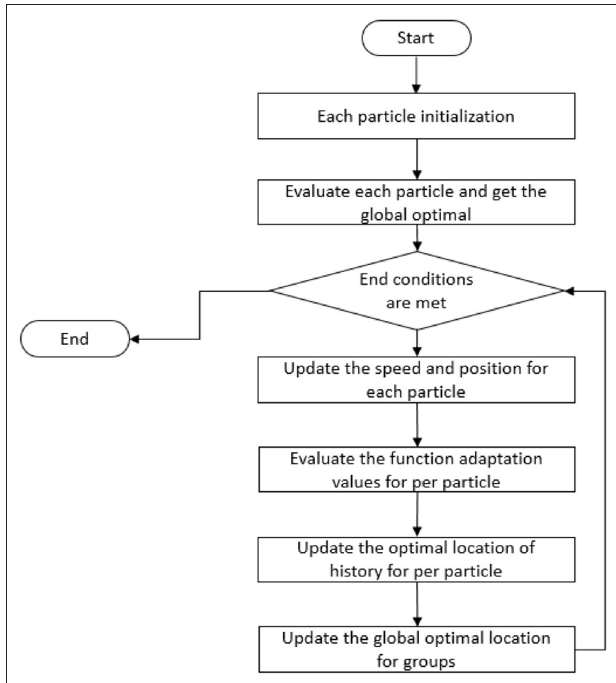
FIGURE 2 | The flow chart of the traditional PSO used as the IK solution of the manipulator.